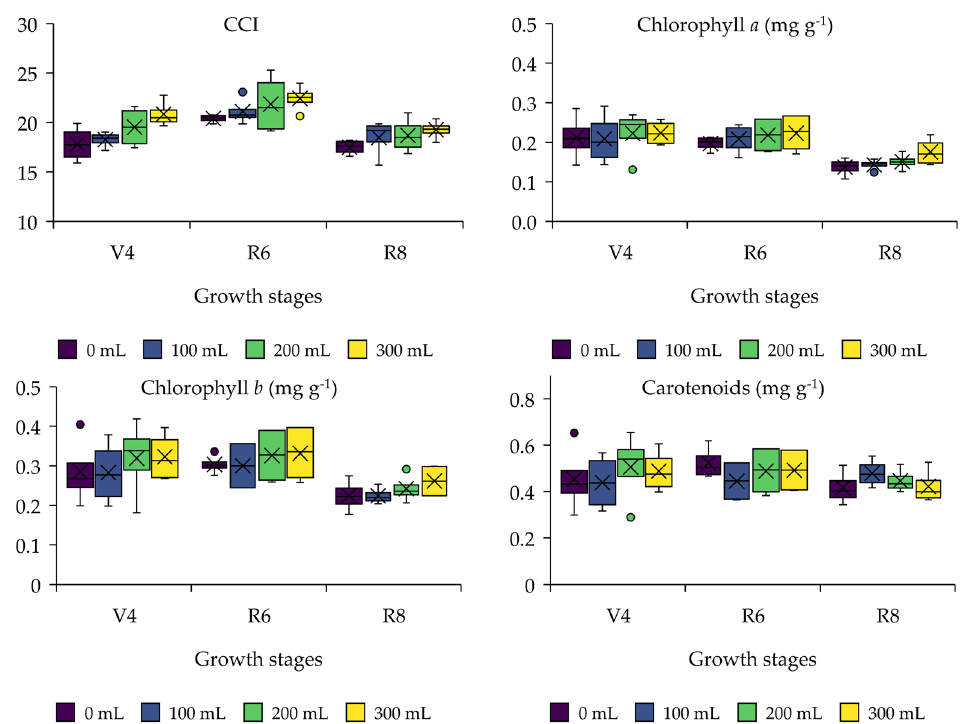
Figure 3. Summary statistics of the effect of phosphate-solubilizing bacteria on pigments. V4, R6, and R8: growth stages; 0, 100, 200, and 300 mL: inoculant